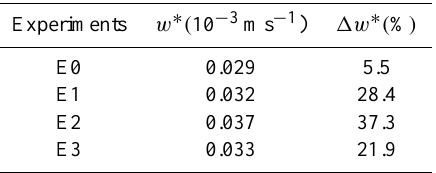
Table 3. The tropical (25 ◦ N–25 ◦ S) upwelling ( w ∗ ) averaged be- tween 70 and 20hPa over the last 10yr of the four simulations, and changes in w ∗ ( (cid:49)w ∗ ) relative to the first 10yr of the corresponding